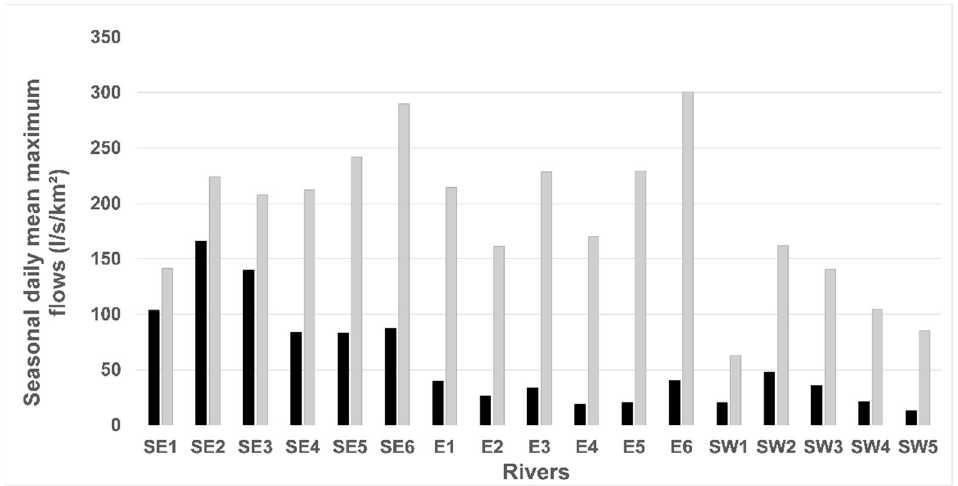
Figure 2. Comparison of maximum daily flow means in winter (black bars) and spring (grey bars).